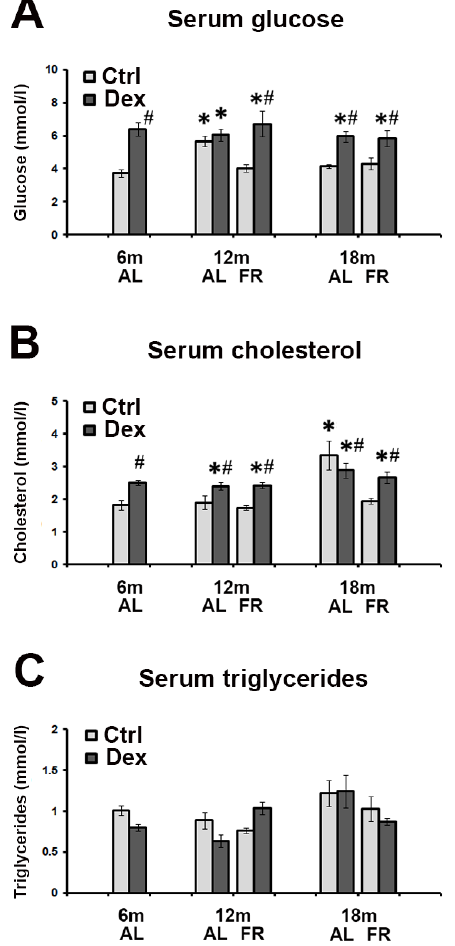
Figure 1. Serum levels of glucose ( A ), cholesterol ( B ) and triglycerides ( C ) in rats treated with dexamethasone (single dose, 4 mg/kg, i.p.) during aging, fed ad libitum (AL) and following food restriction (FR). Data represent the mean ± SEM ( n = 5). * p < 0.05 vs. 6 ‐ month ‐ old rats; # p < 0.05 vs. vehicle ‐ treated rats.